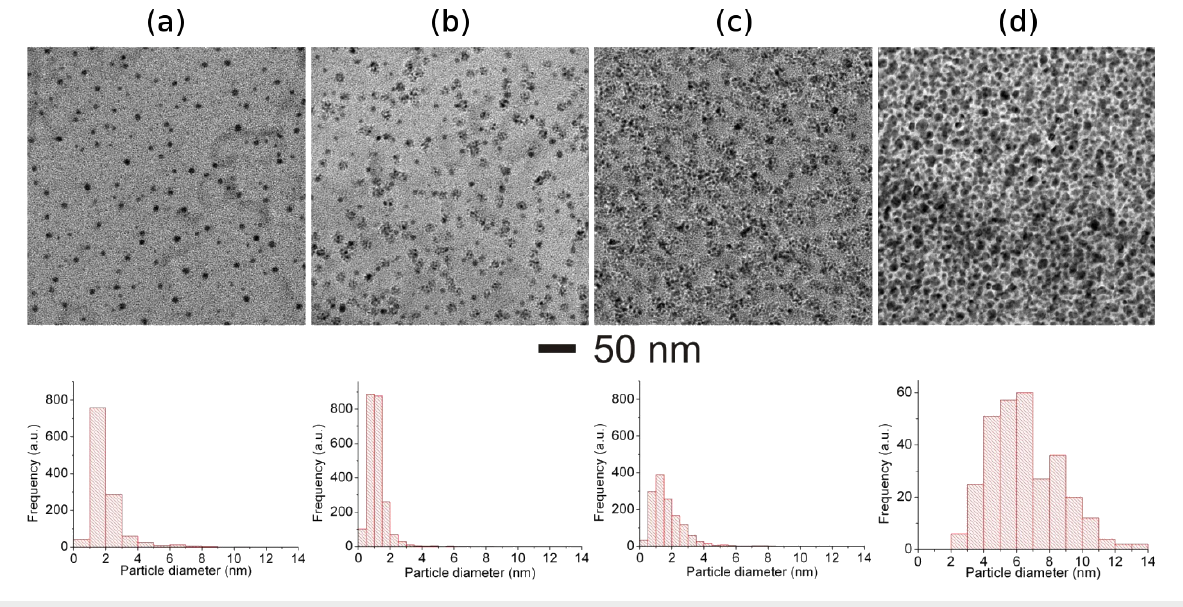
Figure 3: Morphological evolutions in Au–TiO 2 nanocomposite (MVF ≈ 15%) under 100 MeV Ag 8+ ion irradiation at different fluences; Bright field TEM image of: (a) pristine film, (b) 1 × 10 12 ions/cm 2 , (c) 3 × 10 12 ions/cm 2 , (d) 1 × 10 13 ions/cm 2 . Size distributions corresponding to each TEM image are shown below the